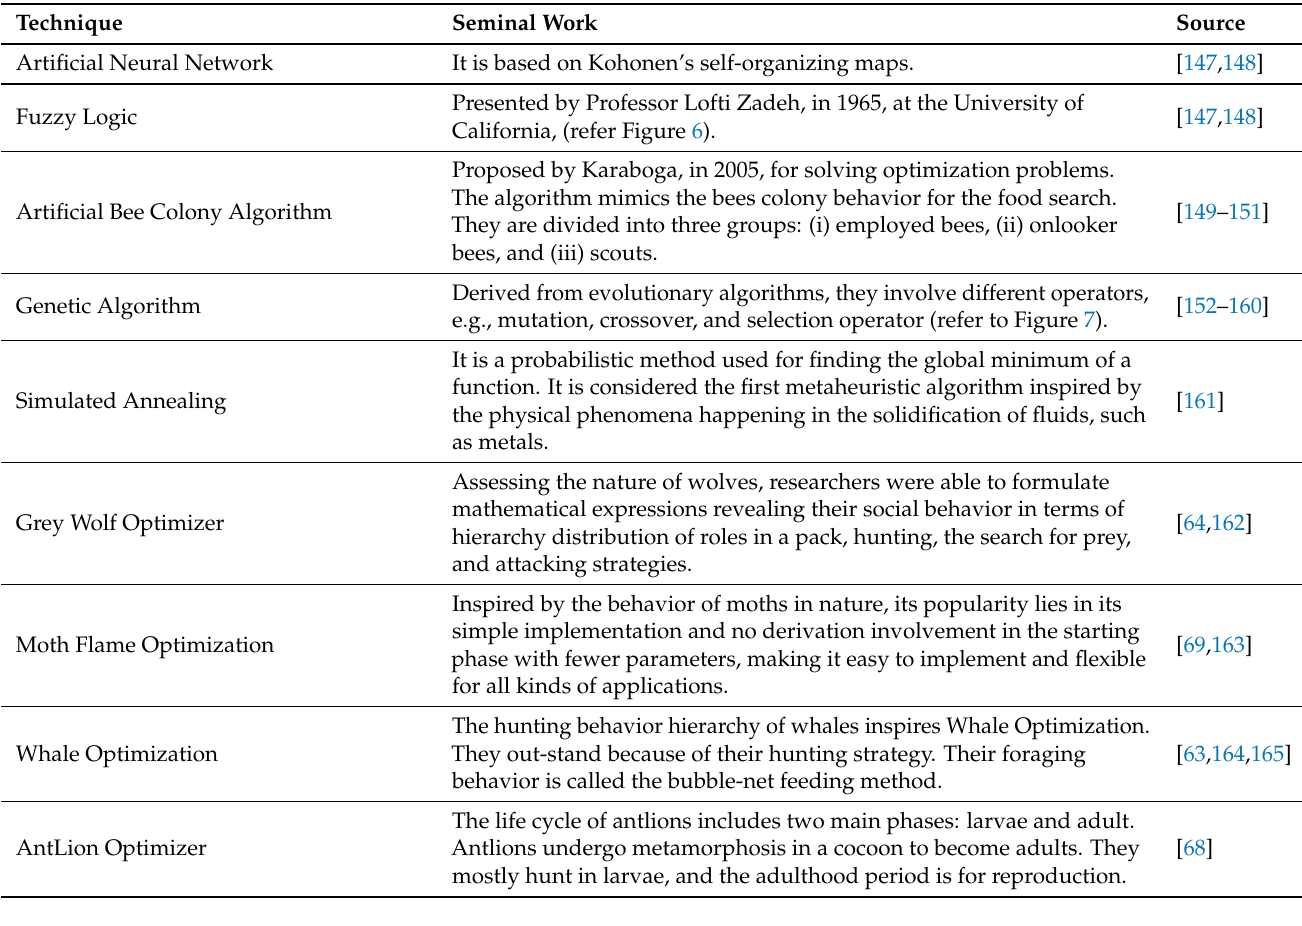
Table 4. Bio-Inspired Algorithms.